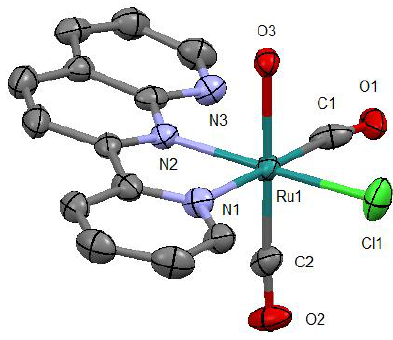
Figure 3. Molecular structure of the cation with atom labels and displacement ellipsoids for non-H atoms drawn at the 50% probability level. All H atoms are omitted for clarity.